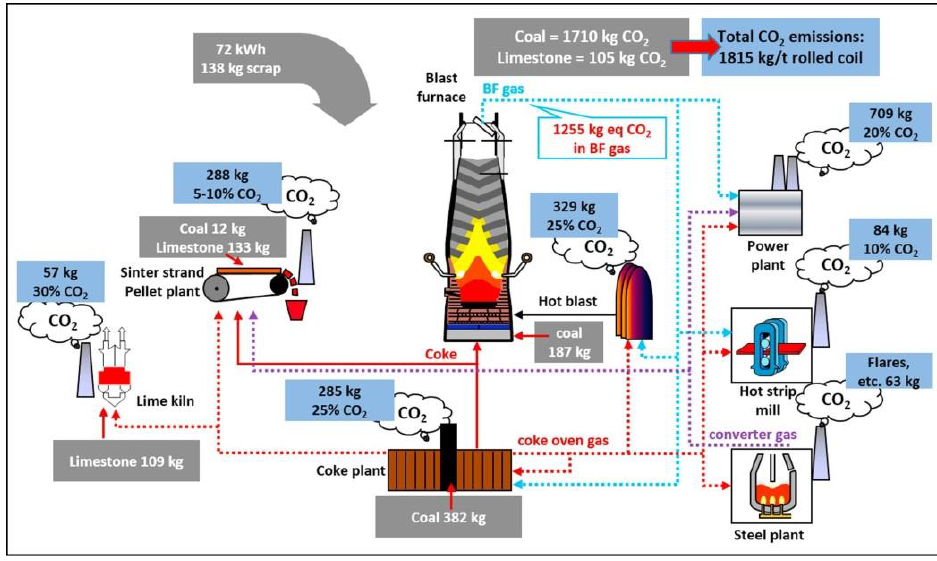
Figure 1. CO 2 emissions in an integrated steel mill [7].